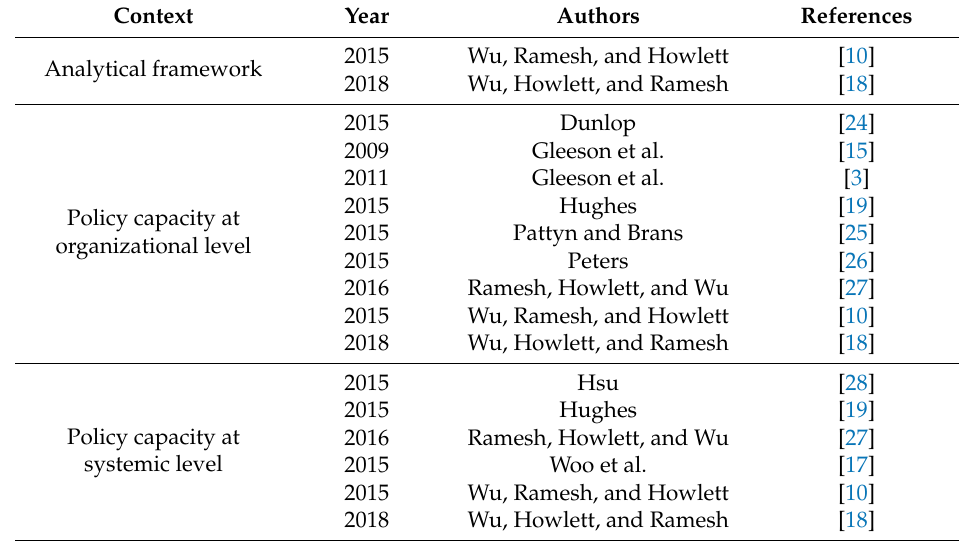
Table 2. The studied literatures related to policy